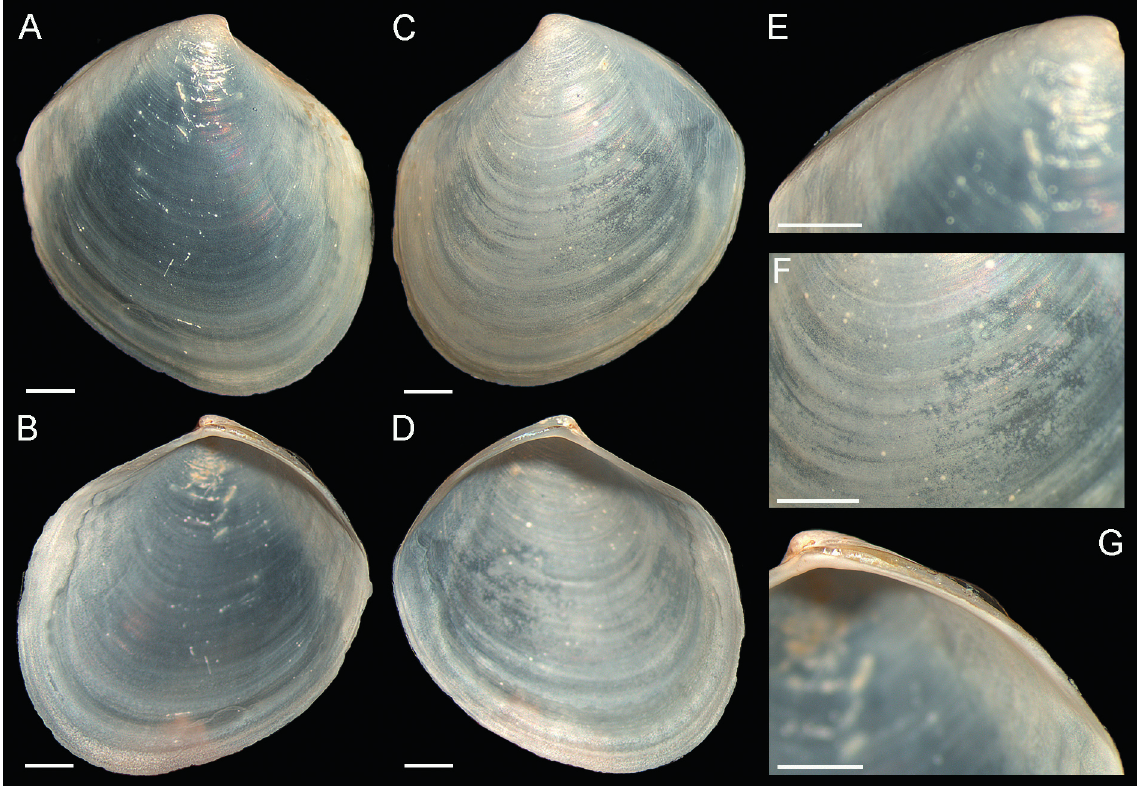
Fig. 12. Thyasira kharkovensis sp. nov., holotype (MIMB 43824). A–D . Exterior and interior views of both valves, shell length 7.4 mm. E . Auricle. F . Sculpture of central part, left valve. G . Hinge plate and ligament, right valve. Scale bars = 1